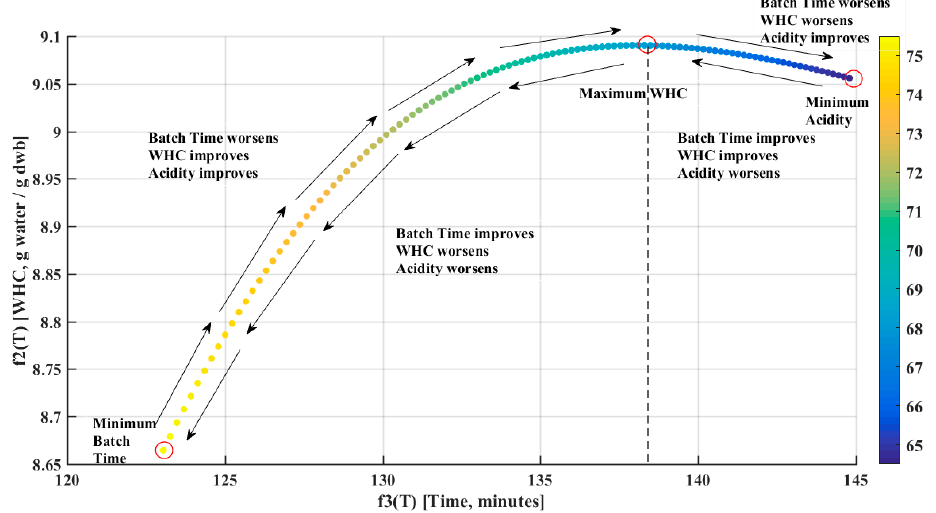
Figure 11. X–Y plane for time and WHC, respectively, of the Pareto-optimal front.